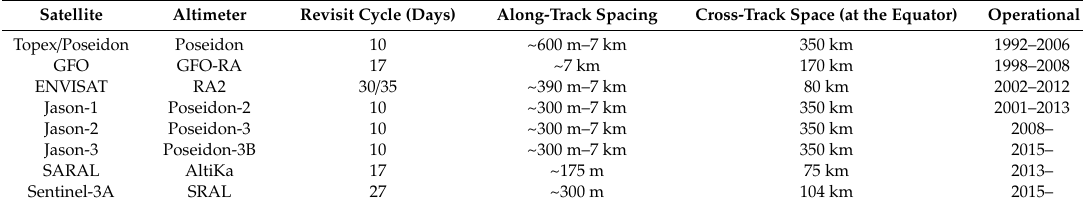
Table 2. Details of di ff erent satellite altimetry missions.